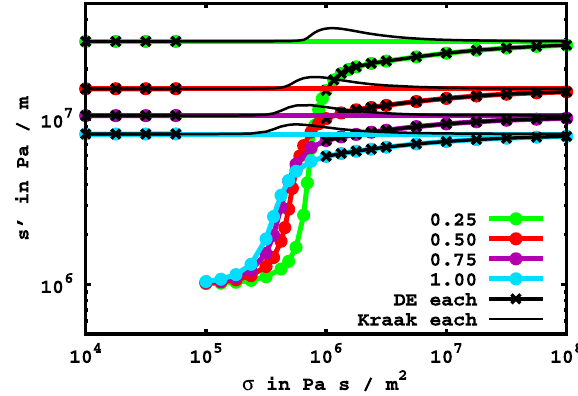
Figure 10. Dynamic stiffness per unit area s 0 for different values of the stiffness per unit area of the solid structure s 0 according to the legend: the exact value, the calculation according to [2] using the standard procedure, the calcula- tion according to the German preamble of [3] (DE), and calculation according to Kraak (22).